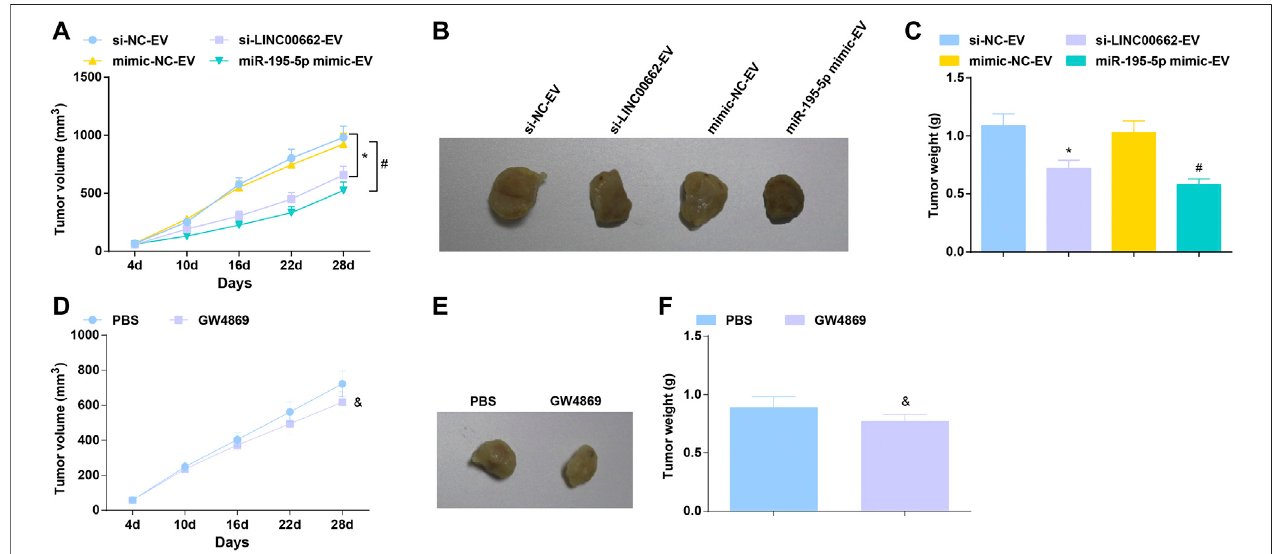
FIGURE 8 | Tumor suppression effect of EVs expressing downregulated LINC00662 or upregulated miR-195-5p. (A,D) Tumor volume changes in nude mice; (B,E) . Representative tumors innude mice; (C,F) Tumorweightin nudemice.* p < 0.05vs. thesi-NC-EV;# p < 0.05vs. themimic-NC-EV group; & p < 0.05vs. thePBS group.